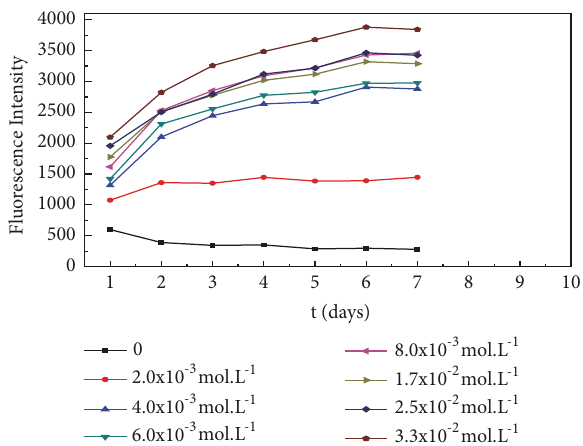
Figure 2: Variations of the fluorescence intensity of the SDS 𝑛 - B 18 H 22 water solution system with standing time.